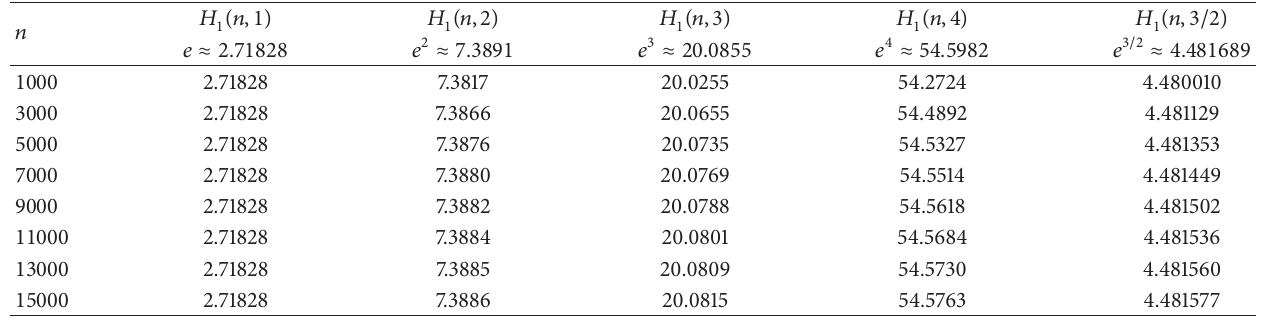
Table 1: Using 𝐻 1 (𝑁,𝜆) to approximate the 𝑒 𝜆 , when 𝜆 = 1,3/2, 2, 3,4 with different 𝑛